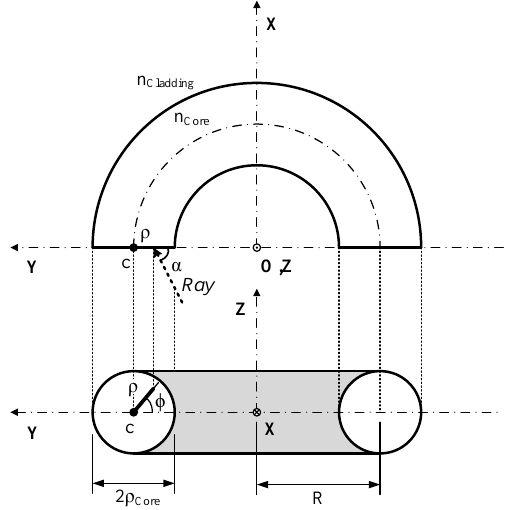
Figure 1. Schematic of a bend fiber section curved with a radius of curvature